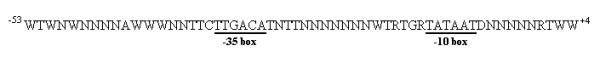
Consensus sequence for E. coli promoters derived after literature review. D = 33.33% each A, C and G; N = 25% each A, C, G and T; R = 50% each A and G; W = 50% each A and T.